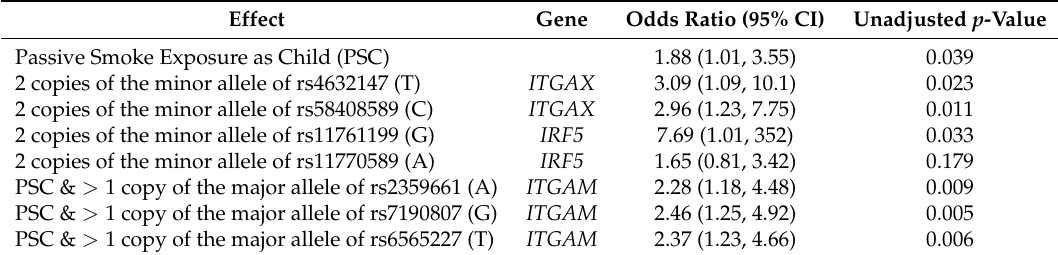
Table 2. Odds ratios with 95% confidence intervals (CI) from a series of logistic regression models. The implied reference category for each odds ratio is the complement of the effect defined in the first